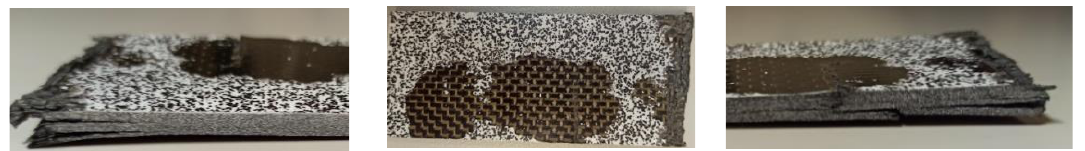
Fig. 9. Damage patterns of CFRP specimen at 113m/s a) Delamination b) Erosion c) Matrix